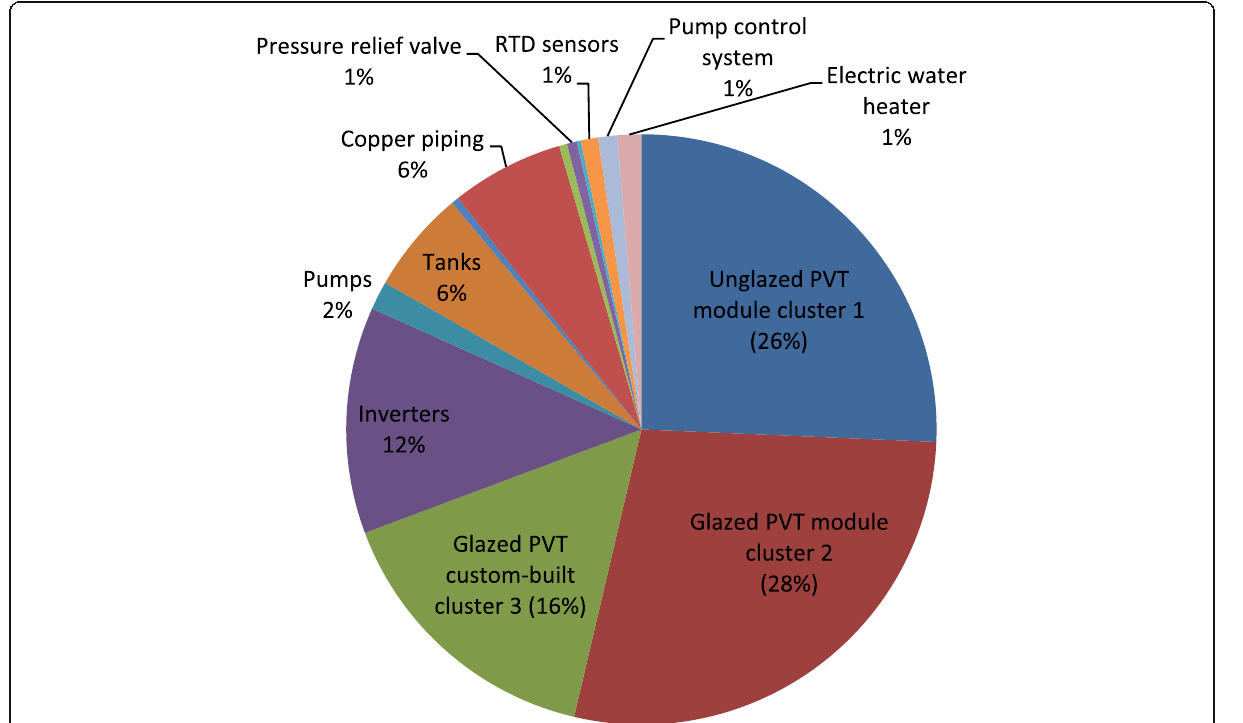
Fig. 3 Distribution of material costs in a typical PVT